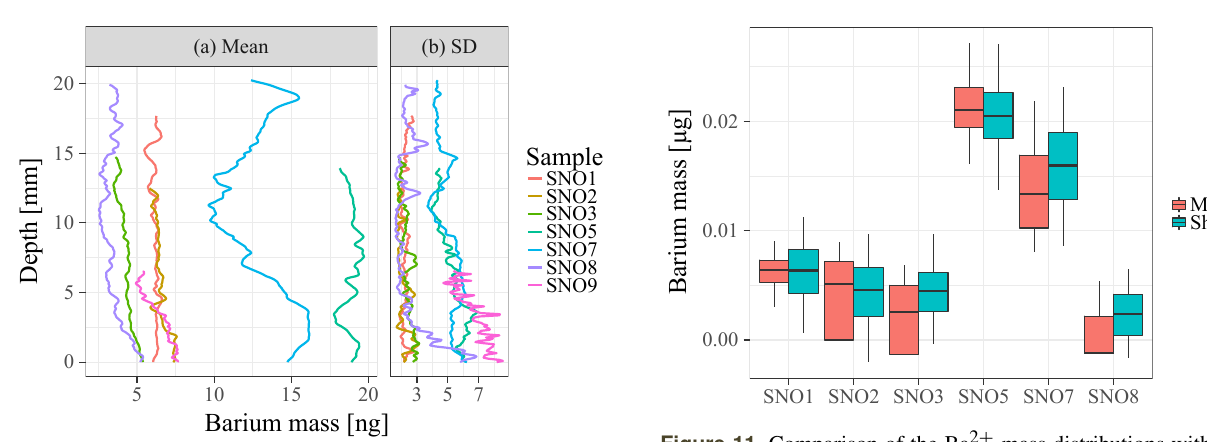
Figure 11. Comparison of the Ba 2 + mass distributions within the matrix (red) and within the macropore sheaths (blue) for the six natural soil